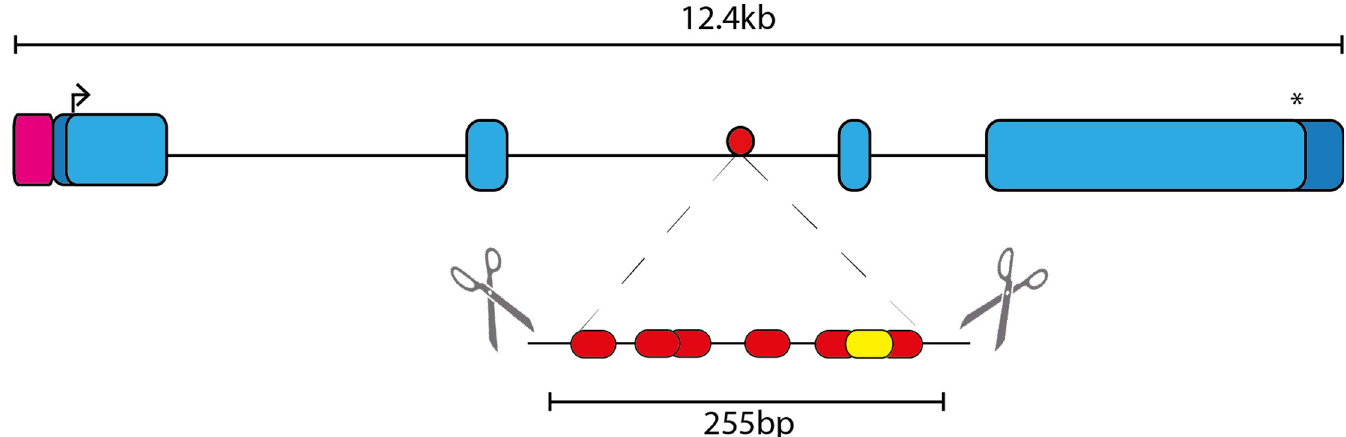
Fig 1. Generation of Nes Enhancer deletion (-255/-255) mouse line. Guide RNAs (scissors) were designed to flank the six SOXB1 sites (red) and the POU site (yellow) within the second intron of the Nestin gene. Arrow indicates start codon, asterisk indicates stop codon, pink square denotes promoter region and dark blue, the 5’ and 3’ UTRs. The 255bp deletion encompasses all SOXB1 sites identified by ChIP-seq.